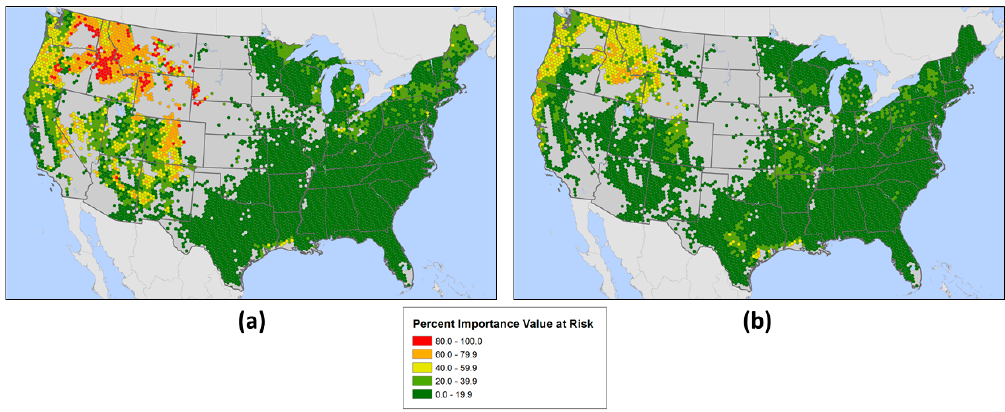
Figure 3. Mean percent host tree Importance Value at Risk (IVAR) for plots within 834 km 2 hexagons, encompassing both native and exotic agents. ( a ) IVAR for insect agents. ( b ) IVAR for disease agents.